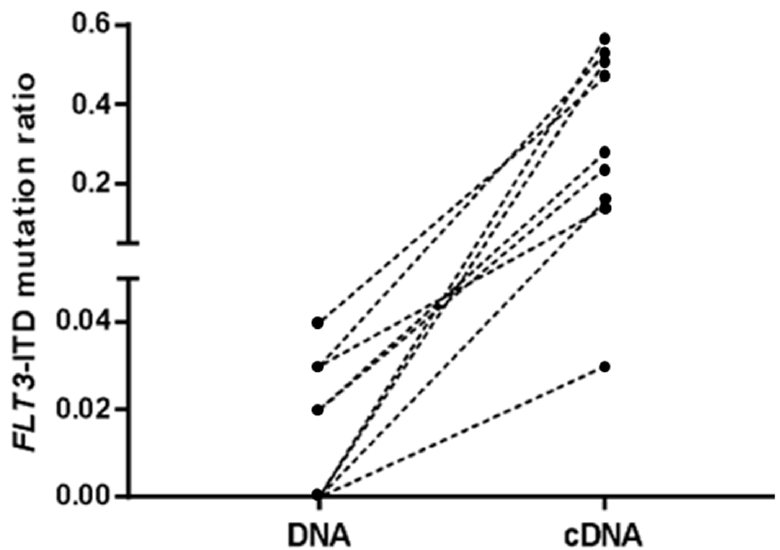
Figure 3. Comparison of FLT3 -ITD mutation ratio between DNA and cDNA in the samples imme- diately prior to progression of the 12 patients who relapsed. FLT3 -ITD mutations were undetectable in three patients in their DNA and cDNA samples.